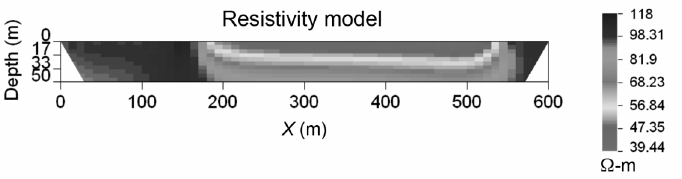
Fig. 15. Result of geophysical inversion, pdL configuration, Model 1, at 2000 days: recovered resistivity.